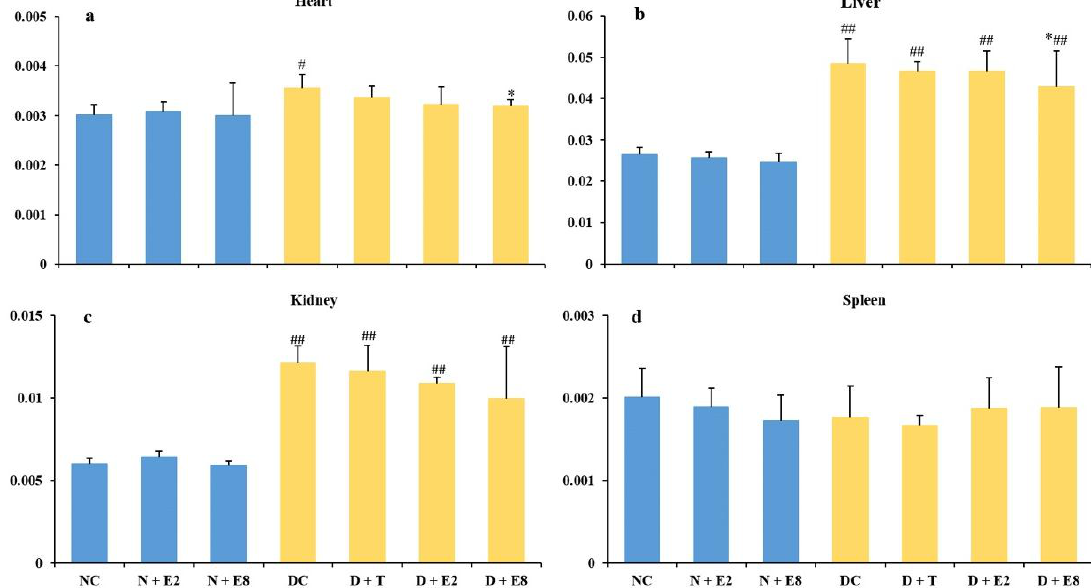
Figure 3. Effects of ECE on organ indexes ( a , heart; b , liver; c , kidney; d , spleen) of normal (blue bars) and diabetic (yellow bars) rats. Results were presented as mean ± SD with five independent experiments ( n = 5). # and ## indicate significant ( p < 0.05) and extremely significant ( p < 0.01) differences between the normal controls (NC) and all other groups, and * indicates significant ( p < 0.05) differences between the diabetic controls (DC) and all other diabetic rats (D + T, D + E2 and D + E8), respectively. N, normal; C, control; D, diabetes; T, tolbutamide at 100 mg/kg; E2, ECE at 200 mg/kg; E8, ECE at 800 mg/kg.